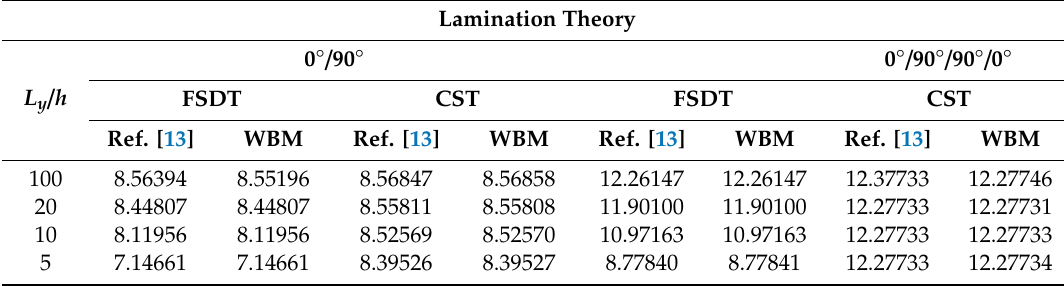
Table 3. The fundamental frequency parameter Ω for a composite plate with the SD-SD boundary condition with variety theory.